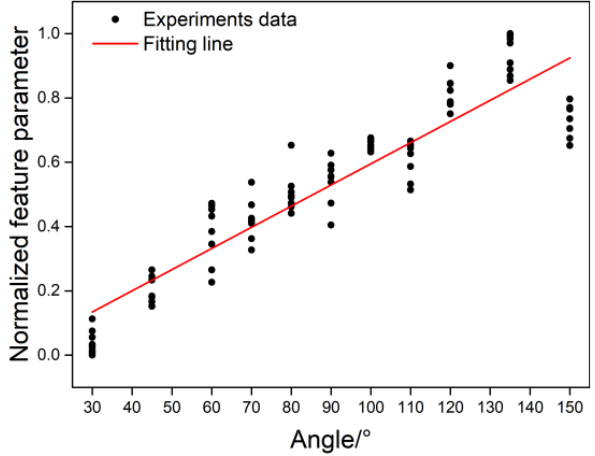
Figure 24. Experimental data and fitting line of the normalized feature parameter versus angles.